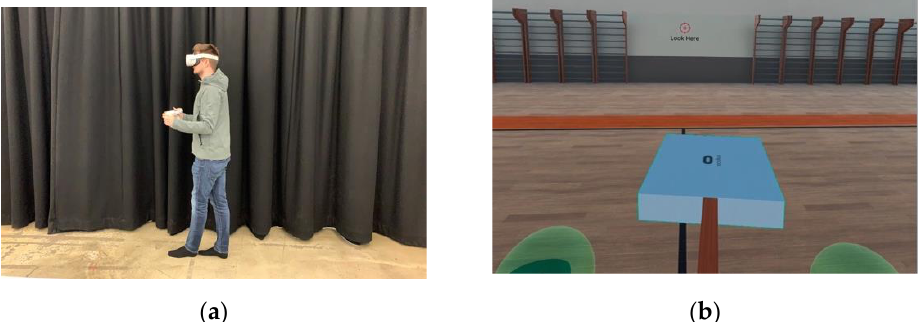
Figure 1. ( a ) A participant wearing the Oculus Quest headset and holding the two hand controllers. Any movements of the head and hands are captured by the motion controllers at 50 Hz. ( b ) An image showing what the participant saw inside the Oculus Quest headset when they were subjected to the ‘tilt’ visual field manipulation. Note the virtual green spheres at the bottom of the image which acted as a standardized visual reference for the hand